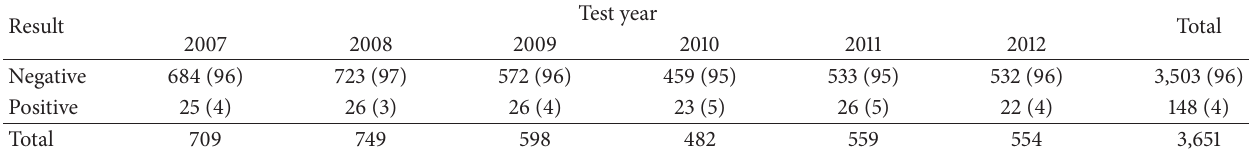
Table 1: Test results of clients who presented for HIV testing at clinic and outreach settings by year, 𝑁 (%), 2007–2012. Result